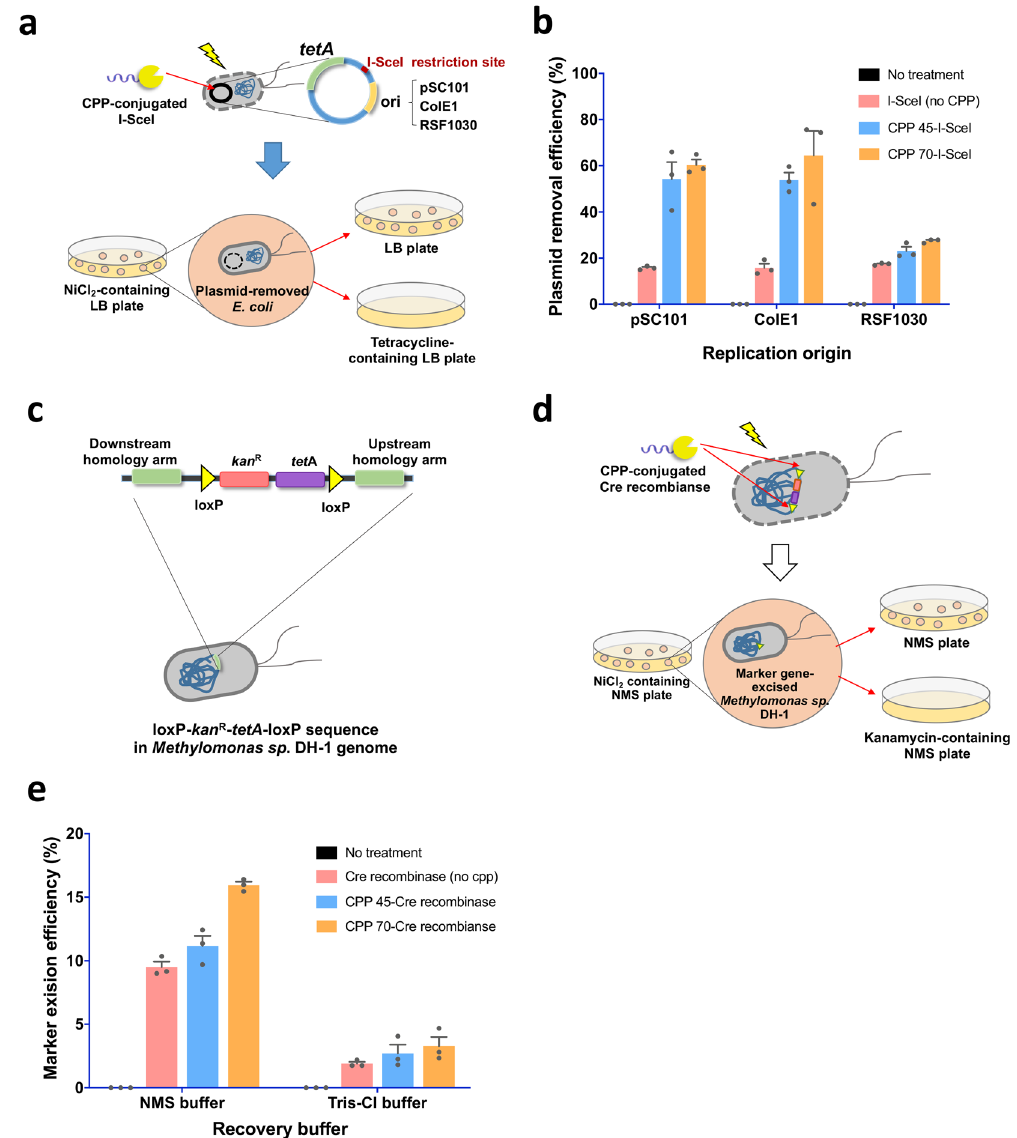
Fig. 7 Plasmid removal using CPP-conjugated I-SceI in E. coli and marker gene excision from the genome of Methylomonas sp. DH-1 using CPP- conjugated Cre recombinase. a, b Plasmid removal in E. coli . c – e Marker gene excision from the genome of Methylomonas sp. DH-1. a The strategy for